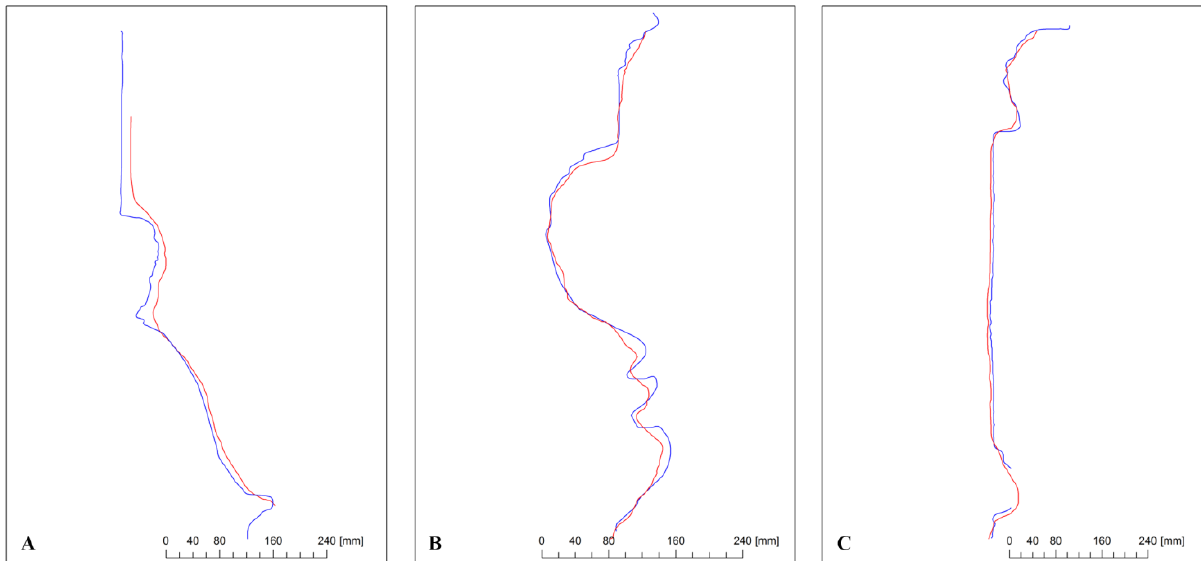
Figure 10. The example of cross-section. Red - Xiaomi point cloud, Blue - TLS data. A) figures of winged female sphinxes B) fire place, C) decorative stucco